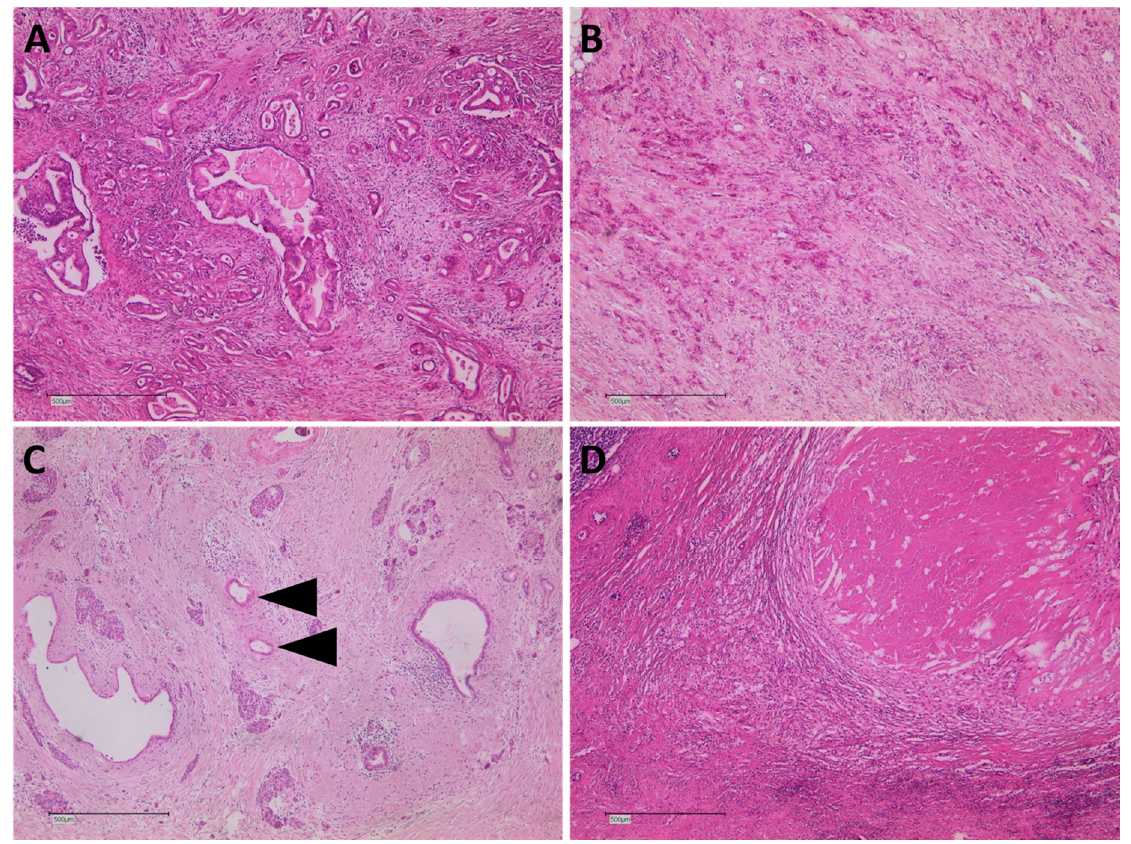
Figure 5. Spectrum of tumor regression grading in pancreatic cancer. ( A ) PDAC with CAP 3 displays abundant vital residual tumor with nearly no regressive changes (H&E, 5×). ( B ) PDAC with CAP 2 shows partial regression with collagen-rich fibrosis and inflammatory infiltrate, but vital residual tumor exceeding rare small groups of tumor cells (H&E, 5×). ( C ) PDAC with CAP 1 is characterized by near-complete response showing only rare single tumor glands embedded in vast collagen-rich fibrosis with residual normal pancreatic tissue (H&E, 5×). ( D ) PDAC with CAP 0 equals complete response with necrosis, fibrosis and inflammatory resorption, but no vital tumor cells (H&E, 5×).